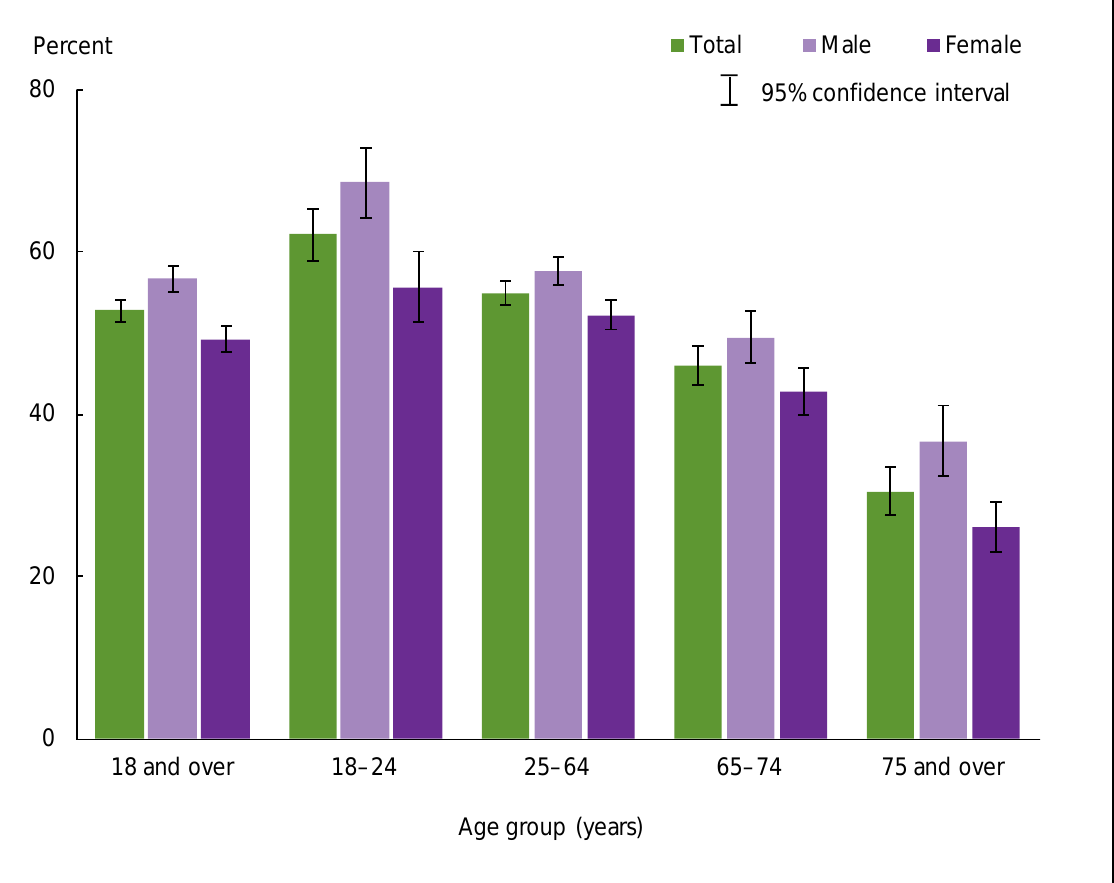
Figure 7.2. Percentage of adults aged 18 and over who met 2008 federal physical activity guidelines for aerobic activity through leisure-time aerobic activity, by age group and sex: United States,